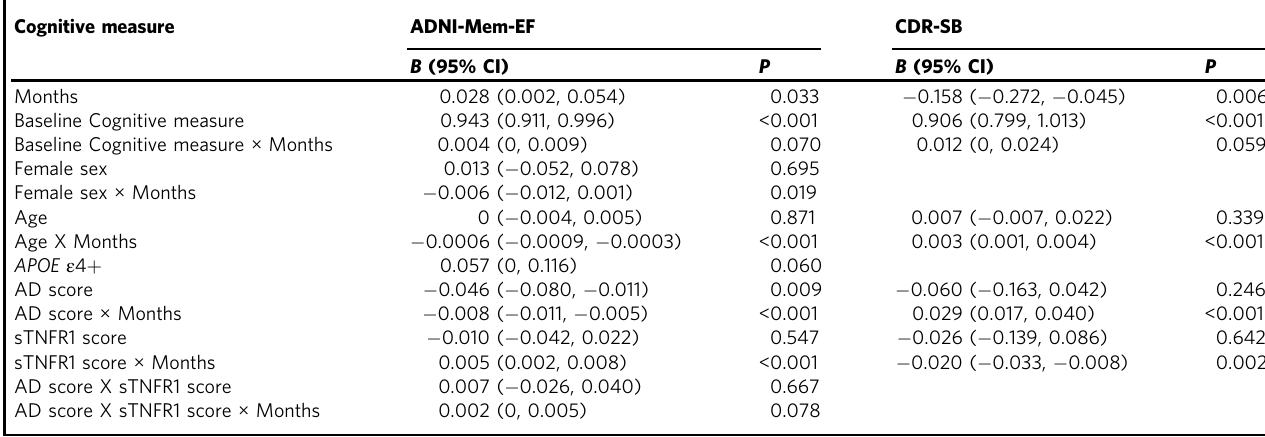
Table 3 Factors associated with rates of cognitive decline in ADNI MCI participants with ADNI-Mem-EF or CDR-SB as outcome, 0-60 months after CSF collection (see Tables S5 and S6 for comparison between models without and with sTNFR1 scores, with improvement in Akaike Information Criterion (AIC) of 11.7 and 8.2; signi fi cant factors highlighted in bold with p < 0.00625 used for CSF biomarkers to adjust for multiple